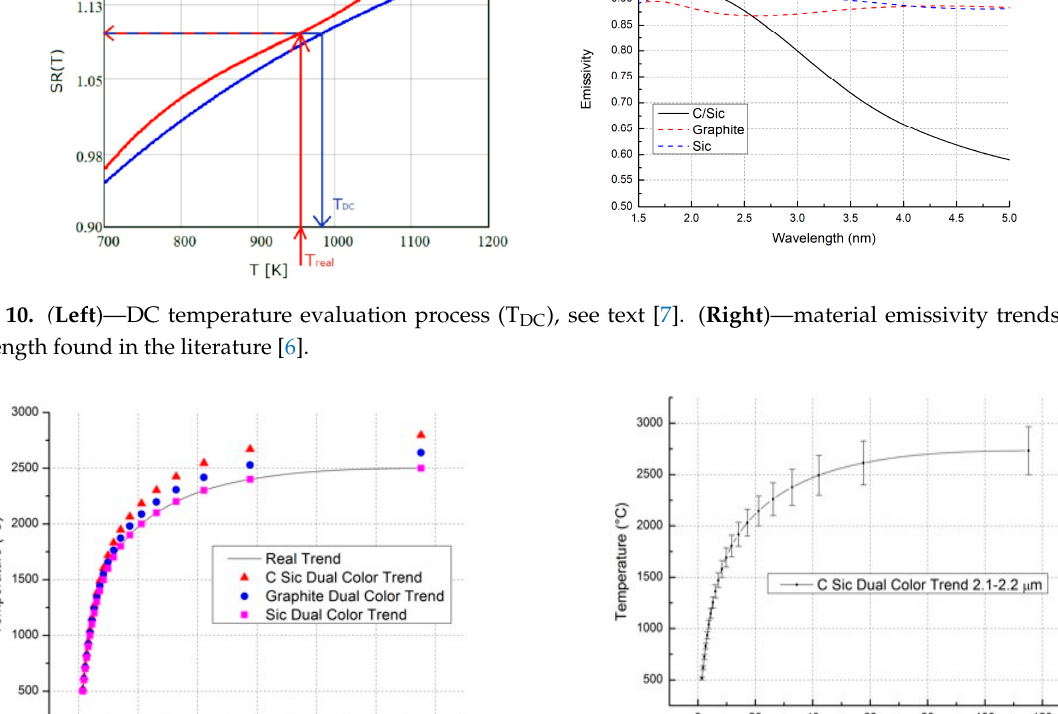
is obtained with C/SiC (9.3% at 2500 °C). The C/SiC curve with lower accuracy shows a trend that increases with temperature. A minimum of 3% at 500 °C and a maximum of 9.3% at 2500 °C has been revealed (right side of Figure 11). Finally, a comparison between standard thermography (single color) simulated data and dual-color simulated data for several emissivity classes of materials has been performed [7]. The results are represented in Figure 12. In particular, three classes of materials have been analysed (at low, medium, and high emissivity), enclosed in three rectangular boxes. An error band of ± 5% has been associated with the real temperature, while dual-color temperature and single-color tem- perature (obtained with a systematic error of − 40% committed over the real emissivity value) were represented by circular and triangular spots, respectively. It is possible to ob- serve that for low emissivity materials dual-color measurements are away from the real